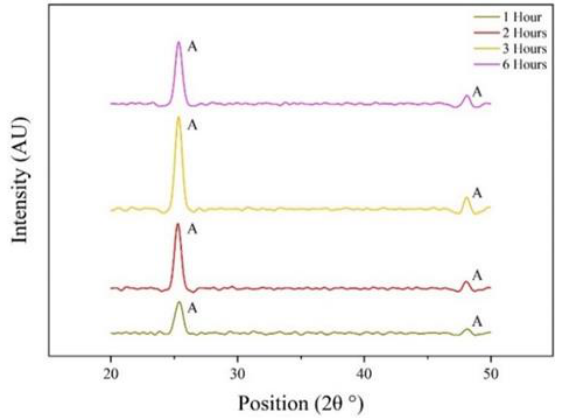
◦ C with different